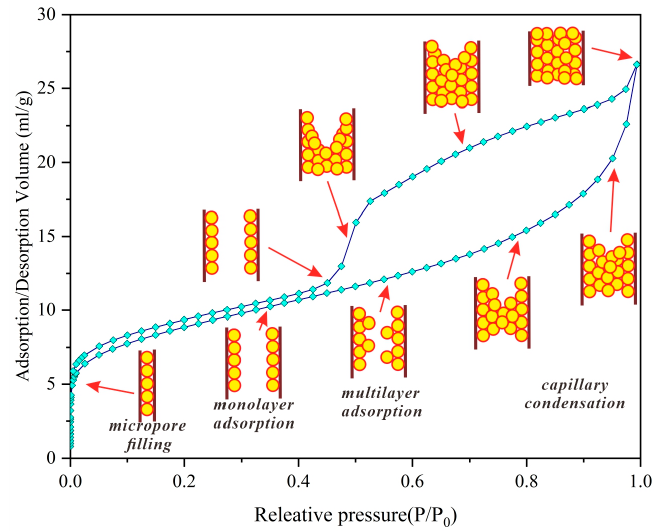
Figure 4. Nitrogen adsorption–desorption isotherms and gas molecular adsorption mode of the shale samples.